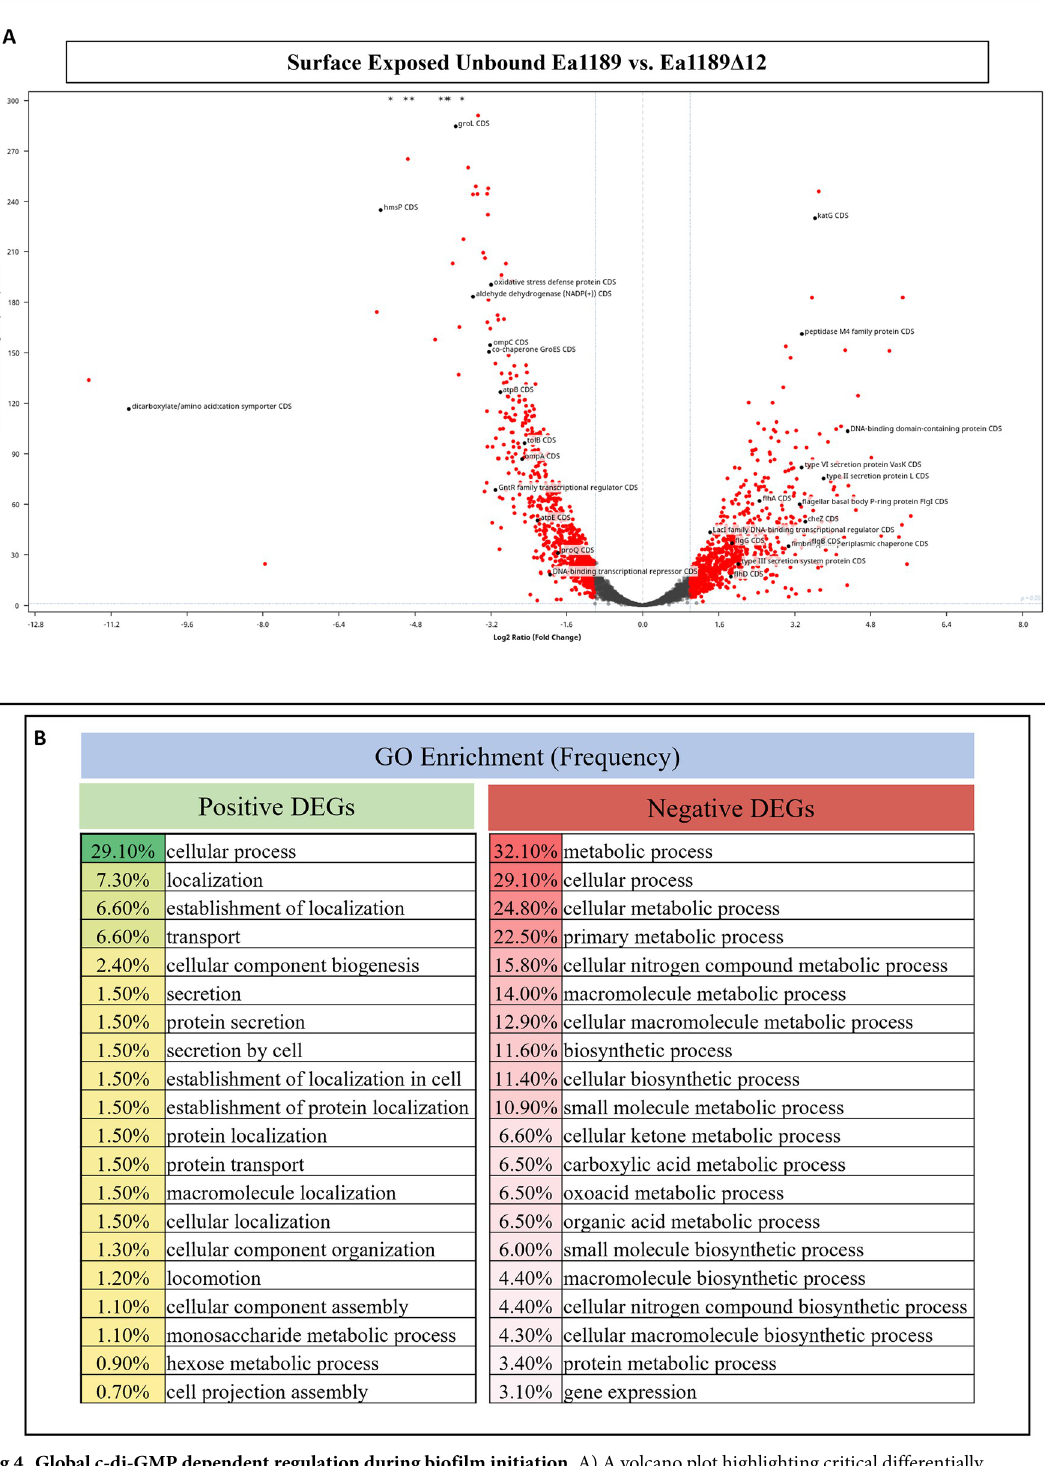
Fig 4. Global c-di-GMP dependent regulation during biofilm initiation. A) A volcano plot highlighting critical differentially expressed genes (DEGs) within surface exposed WT Ea1189 vs. Ea1189 Δ 12 cells analyzed via RNA-seq analysis. A DESeq2 FDR cutoff p-value of 0.05 was used and all DEGs highlighted in red have a two fold change (log2) in expression. The comparison revealed a total of 320 positively and 235 negatively expressed DEGs with functions including metabolism, extracellular appendage regulation and overall transcriptional/post-transcriptional regulators. B) GO enrichment analysis showing the top 20 overrepresented categories for the positive and negative DEGs, along with the overall frequency of gene/target occurrence within the DEG list. https://doi.org/10.1371/journal.ppat.1010737.g004 PLOS Pathogens| https://doi.org/10.1371/journal.ppat.1010737 August 1,